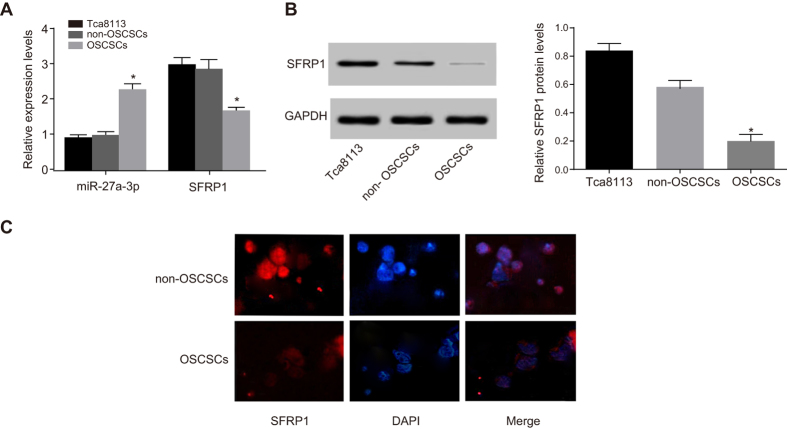
The expression of miR-27a-3p and SFRP1 in Tca8113 cells, non-OSCSCs and Tca8113 OSCSCs.(A) The mRNA expression of miR-27a-3p and SFRP1 in the three cell types detected by qRT-PCR. (B) The protein expression of SFRP1 in the three cell types detected by Western blotting. (C) SFRP1 expression in non-OSCSCs and OSCSCs detected by immunofluorescence. In A and B, *represents P < 0.05 comparisons with Tca8113 cells and non-OSCSCs. OSCSCs, oral squamous carcinoma stem cells; SFRP1, secreted frizzled-related protein 1; qRT-PCR, quantitative real-time polymerase chain reaction.